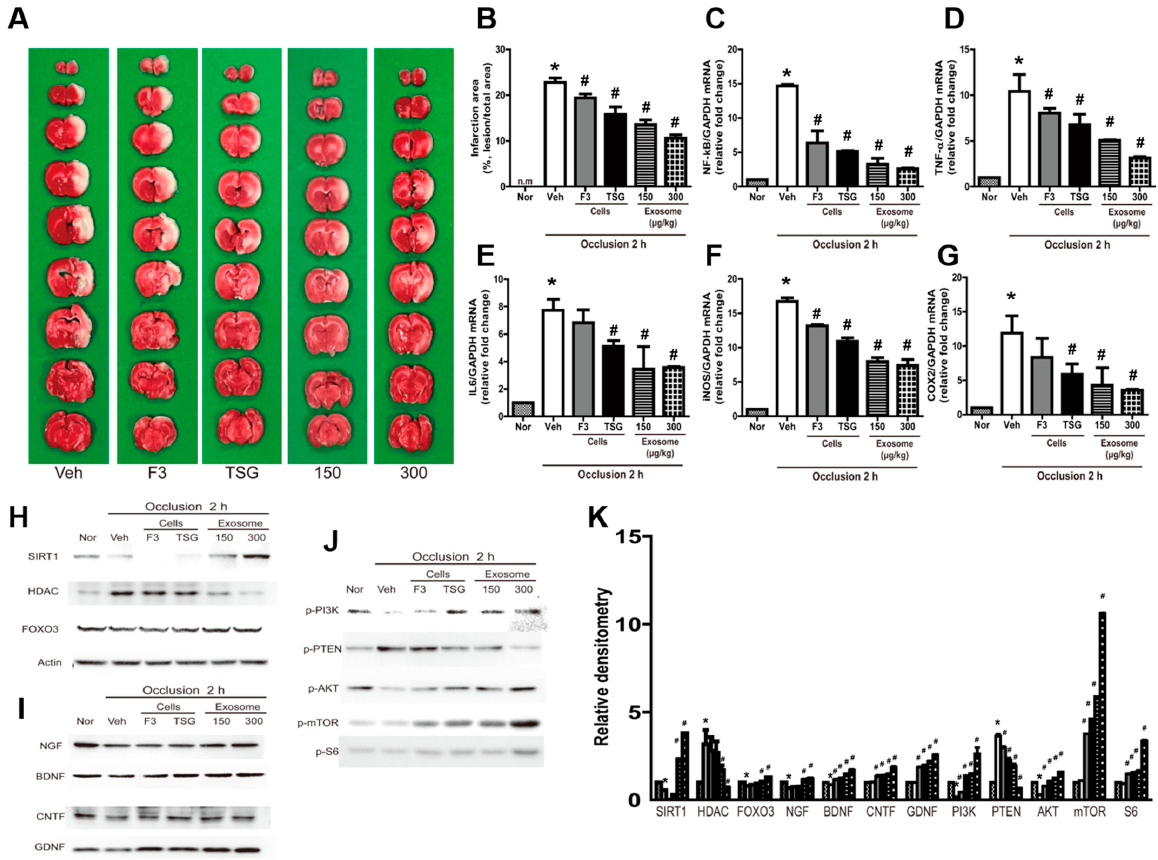
Figure 4. Neuroprotective effects of exosomes in middle cerebral artery occlusion (MCAO) animals.